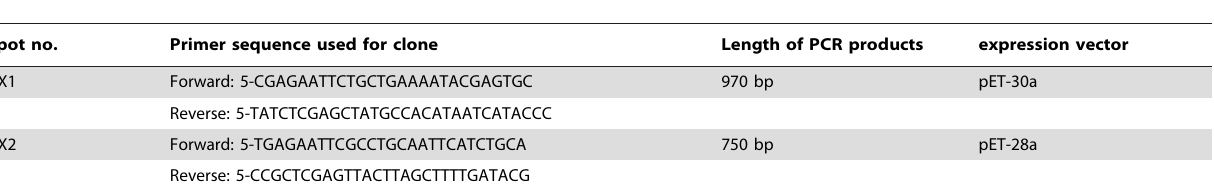
Table 2. Primer sequences used for cloning immunoreactive genes candidates.